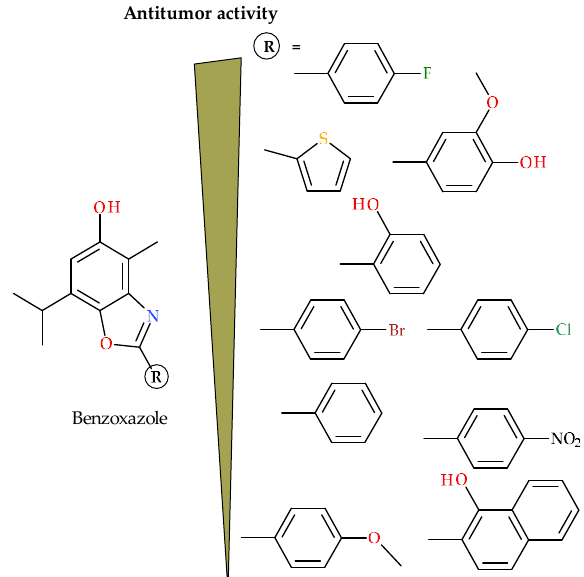
Figure 3. Effects of various substituents on position 2 of benzoxazole ring on antitumor activity of compound.